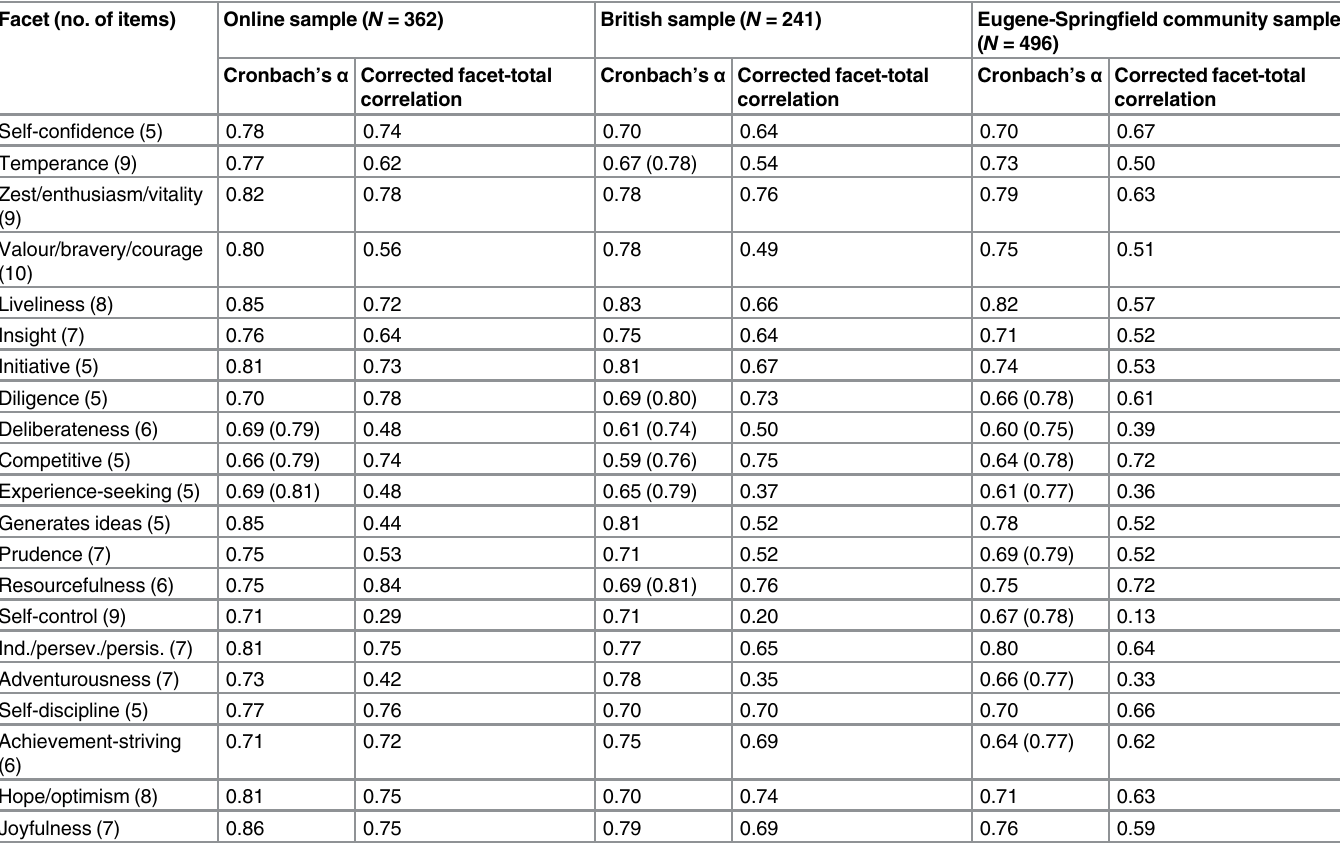
Table 1. Internal Reliabilities of IPIP Facet Scales and Corrected Facet-Total Correlations in Study Samples. Facet (no. of